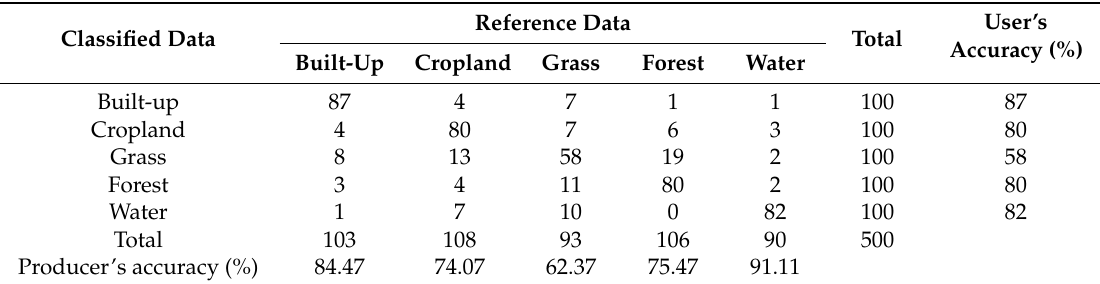
Table A1. Error matrix for the classified 1995 LULC map.